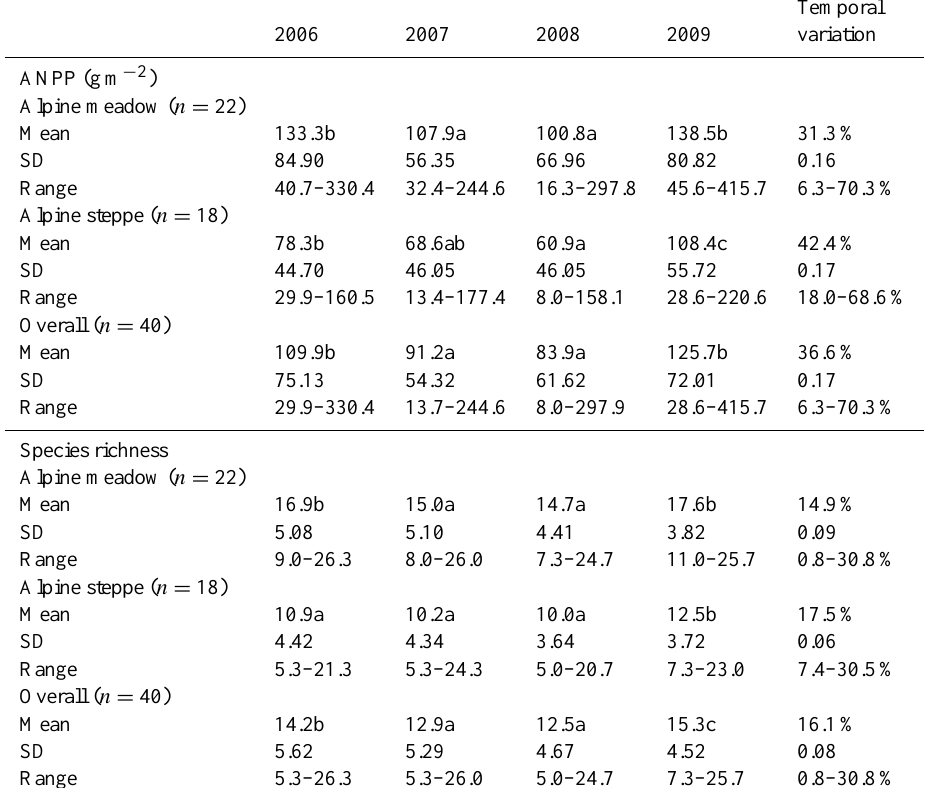
Table 2. Aboveground net primary production (ANPP, gm − 2 ) and species richness in the Tibetan grasslands from 2006–2009. Mean, standard deviation (SD) and range of observations are shown. Different letters indicate statistically significant differences at P < 0 . 05. Temporal variations were calculated as the coefficient of variation of ANPP over the 4-year